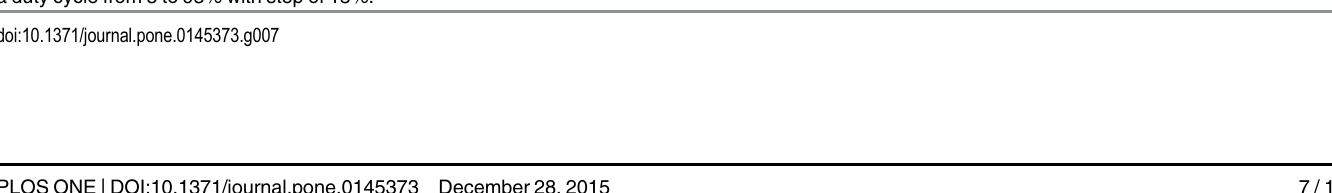
PLOS ONE | DOI:10.1371/journal.pone.0145373 December 28,